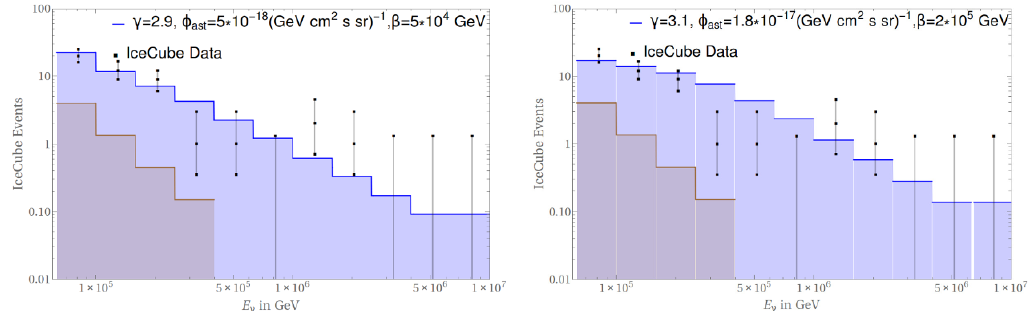
= 1 (cid:2) 10 (cid:0) 17 (GeV cm 2 s sr) (cid:0) 1 (right). astro